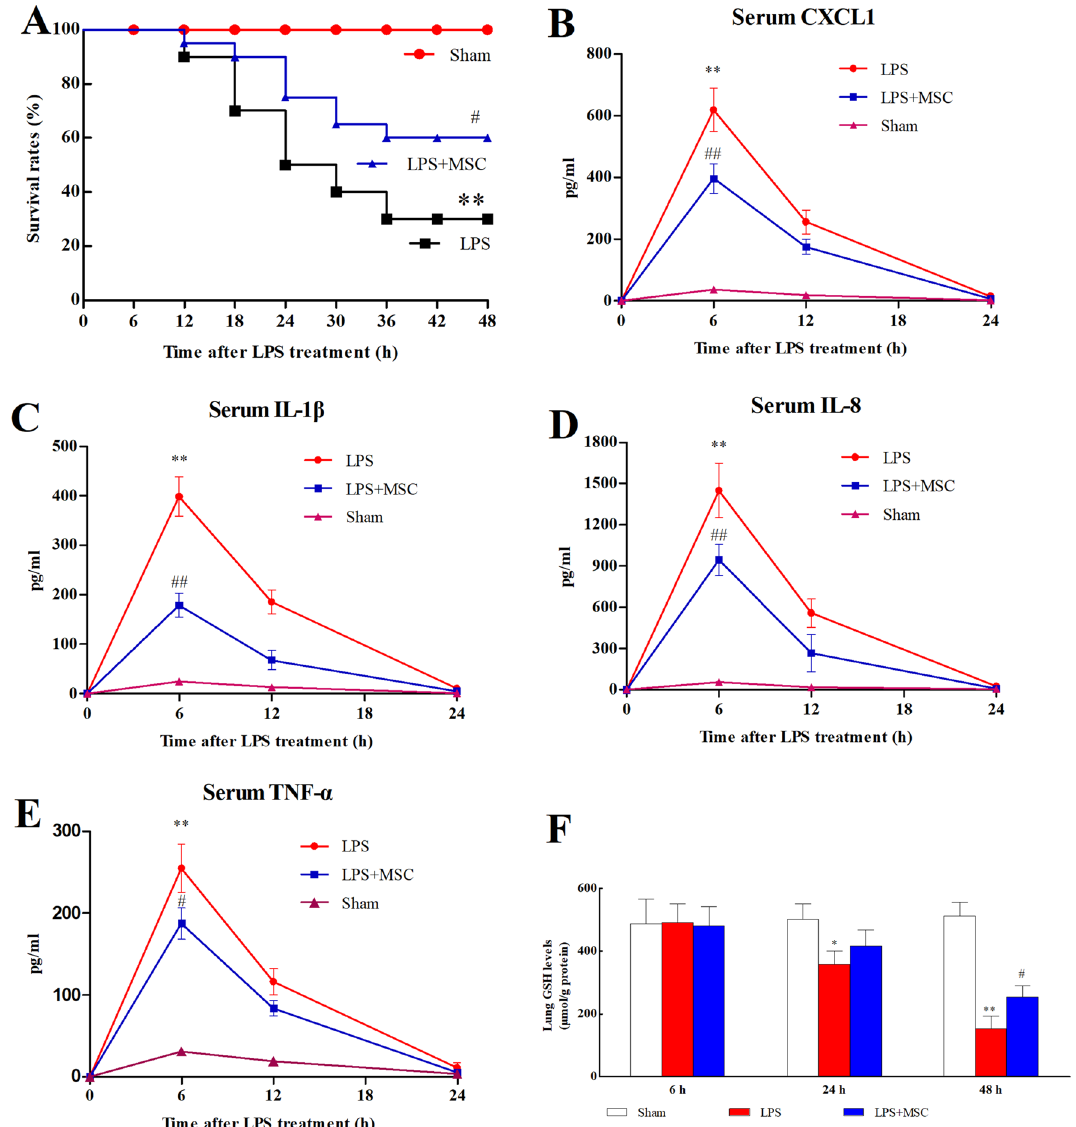
Figure 2. Assessment of survival rates, systemic inflammation, and oxidative stress injury. ( A ) Assessment of survival rates. The serum levels of CXCL-1 ( B ), IL-1β ( C ), IL-8 ( D ), and TNF-α ( E ) were detected. The levels of SOD ( F ), MDA ( G ), GSH ( H ), and MPO ( I ), as indicators of oxidative stress injury, were detected. * P < 0.05 versus the Sham group; # P < 0.05 versus the LPS group; ** P < 0.01 versus the Sham group; ## P < 0.01 versus the LPS group. Values are expressed as the mean ±